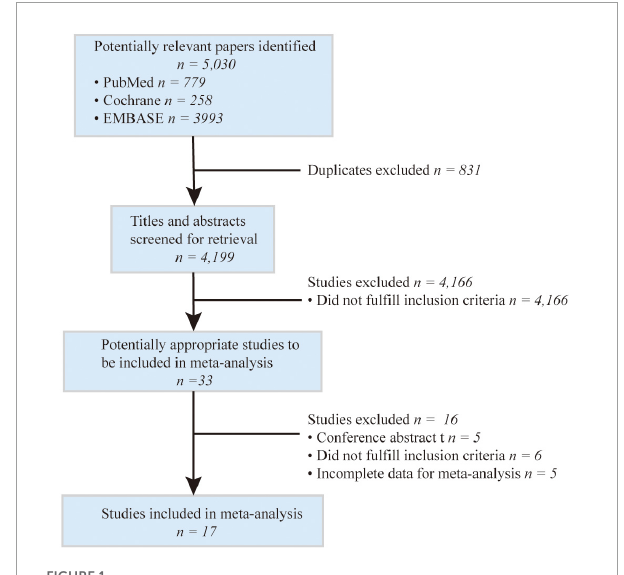
FIGURE1 PRISMA Flow chart of the study collection for the present review and meta-analysis.